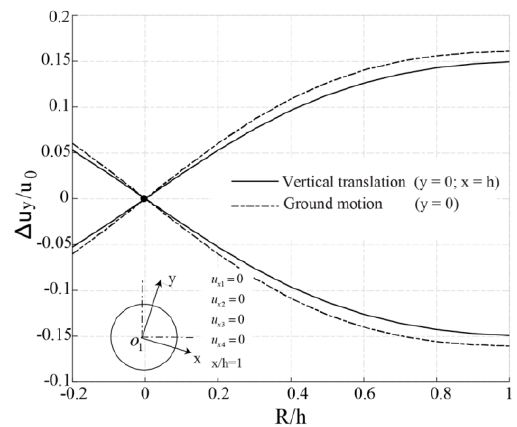
Figure 11. Superposition of vertical translation and vertical ground motion.